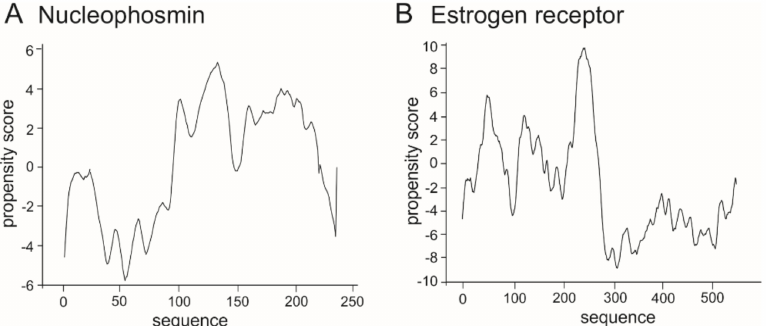
Figure 7. Prediction of propensity of LLPS formation for representative LLPS-enabled proteins. ( A ) nucleophosmin [P06748], ( B ) estrogen receptor